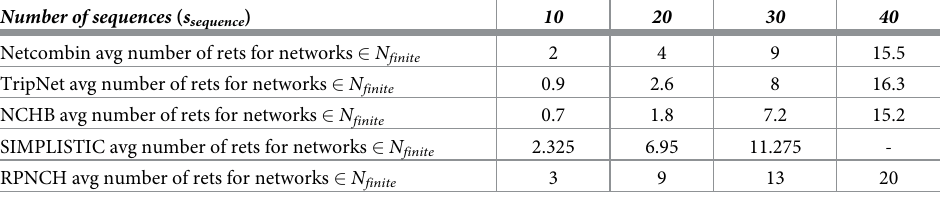
Table 3. The average number of reticulation nodes (rets for short in table) results for the networks that belong to N finite for Netcombin, TripNet, NCHB, SIMPLISTIC, and RPNCH. Number of sequences ( s sequence )